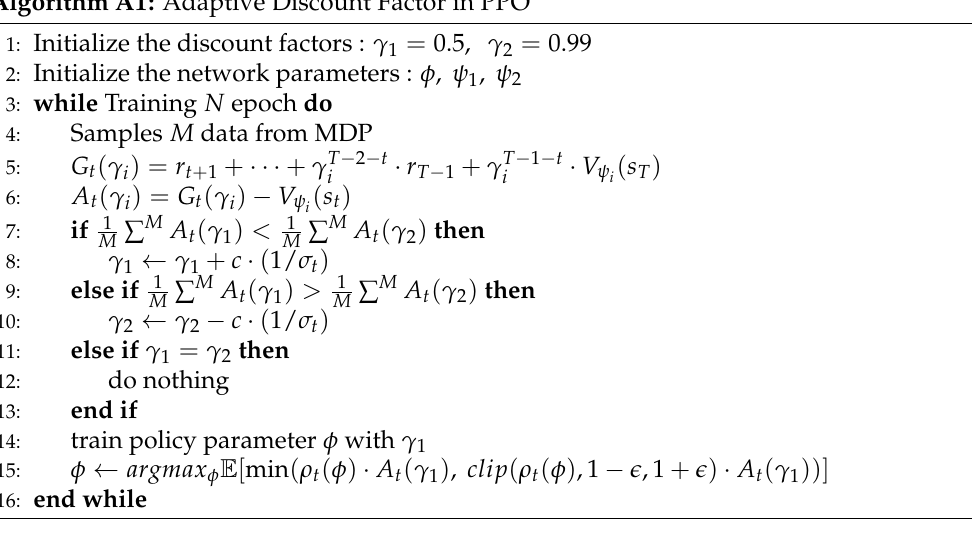
Algorithm A1: Adaptive Discount Factor in PPO